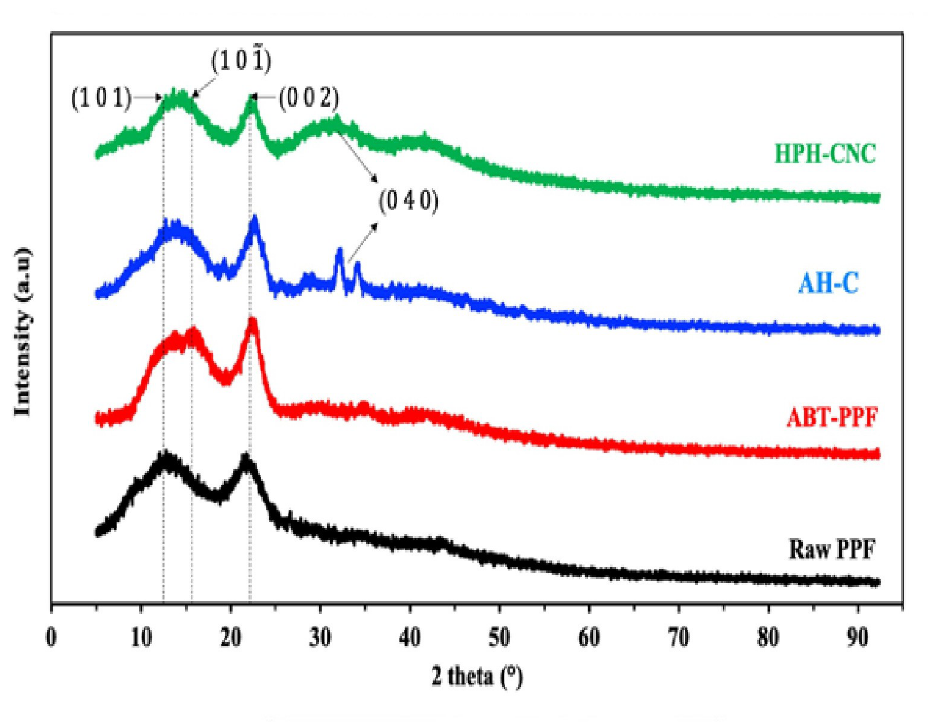
Fig 3. XRD diffractograms of Raw PPF, treated PPF, AH-C and HPH-CNC.